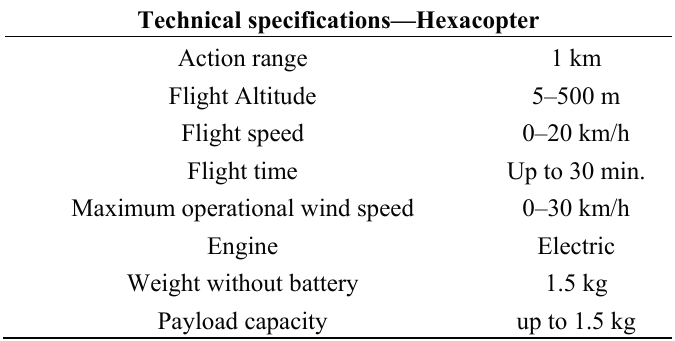
Table 3. Technical specifications of the Hexacopter XL UAS